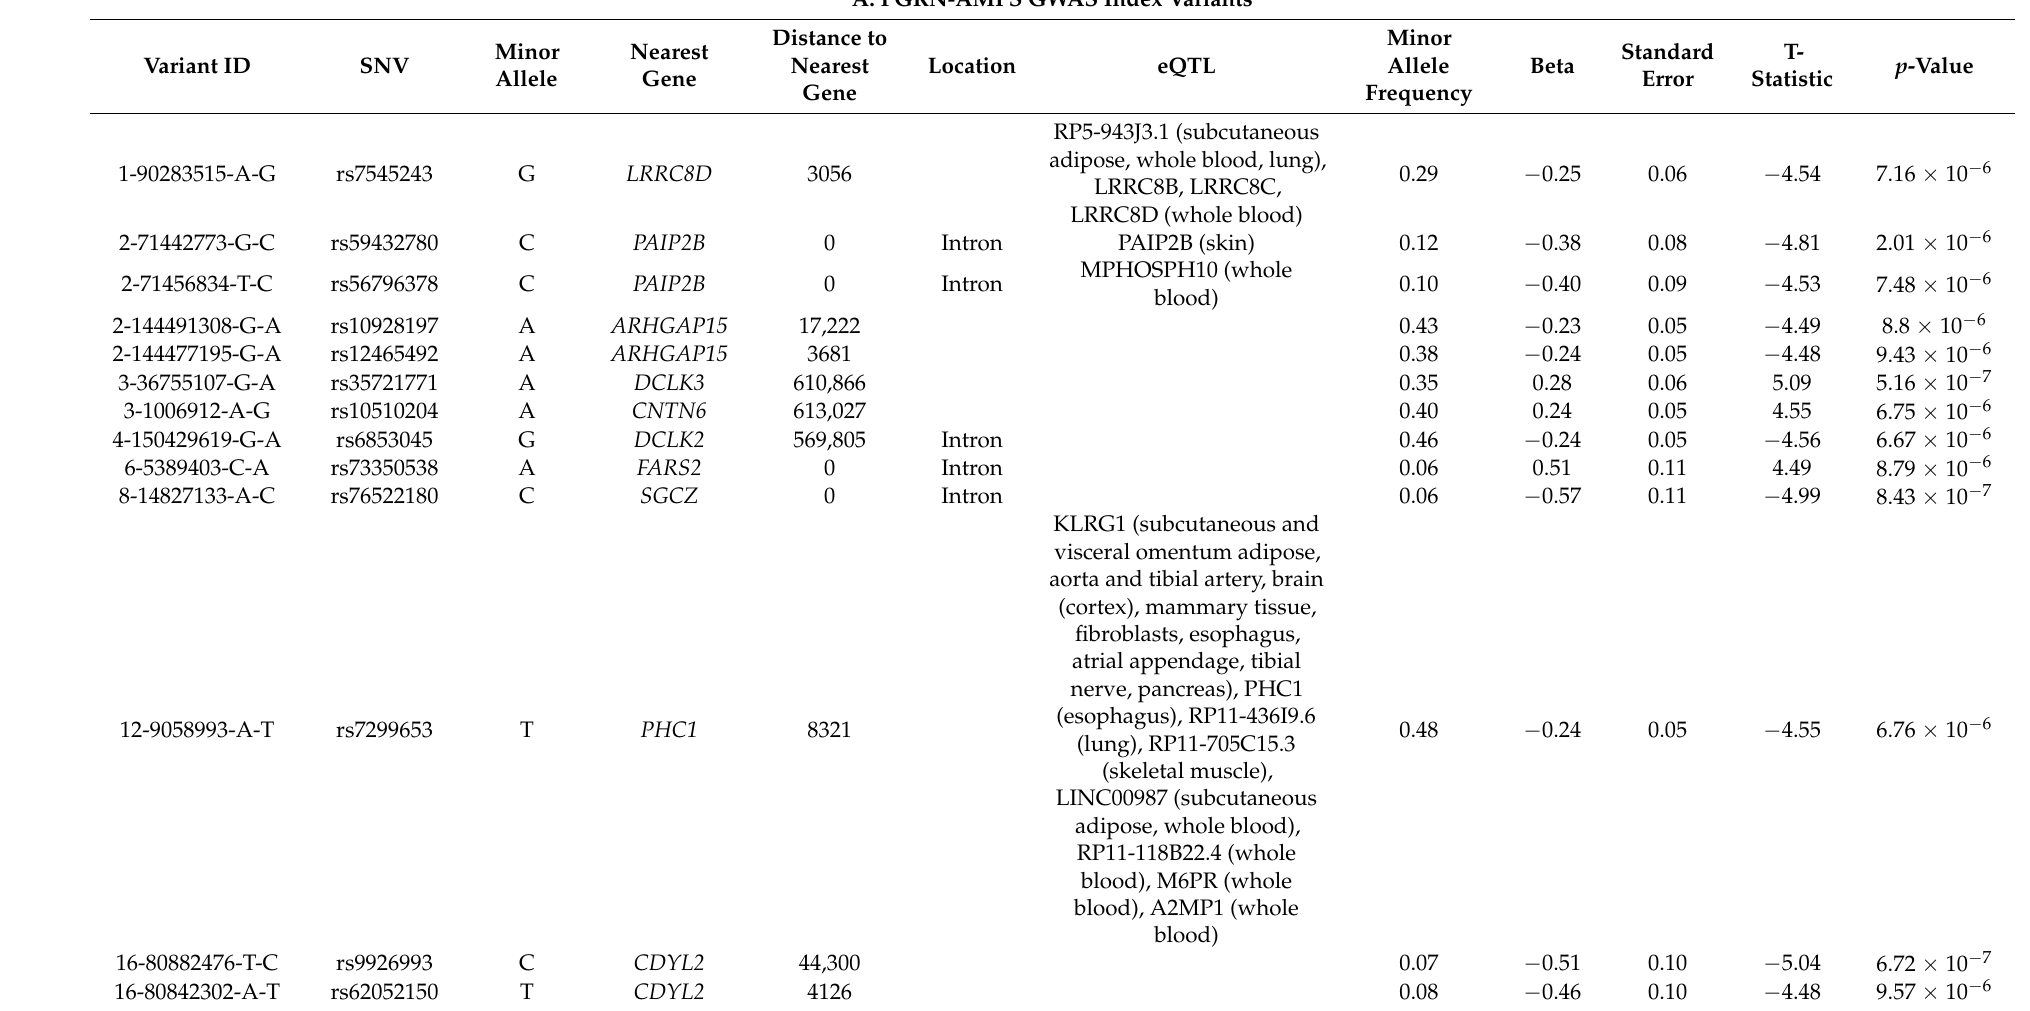
Table 2. Index variants by